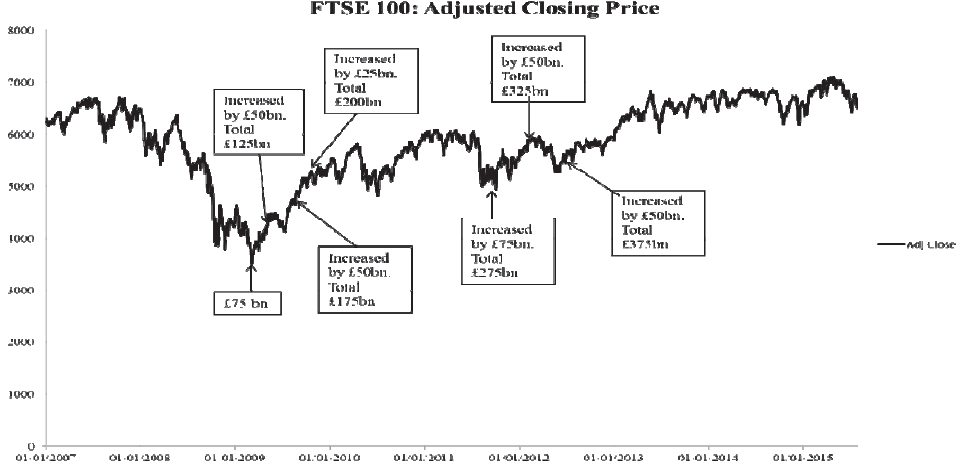
Fig. 1: FTSE 100 adjusted closing prices and the QE